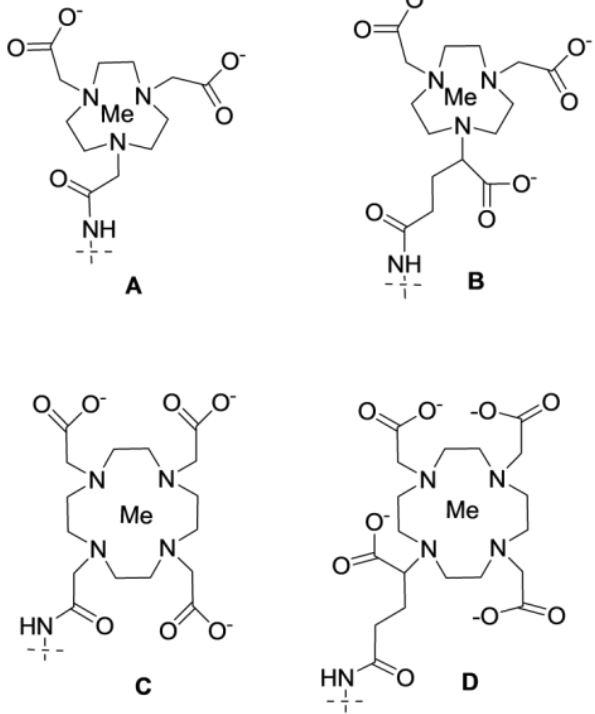
Figure 11. Macrocyclic chelators NOTA ( A ), NODAGA ( B ), DOTA ( C ), and DOTAGA ( D ) conjugated to the amino group of synthetic affibody molecules.